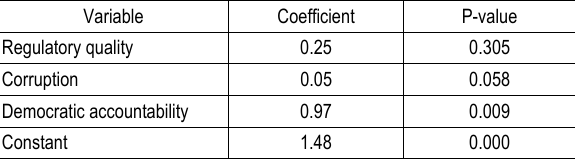
Table 5. Investment and institutional quality